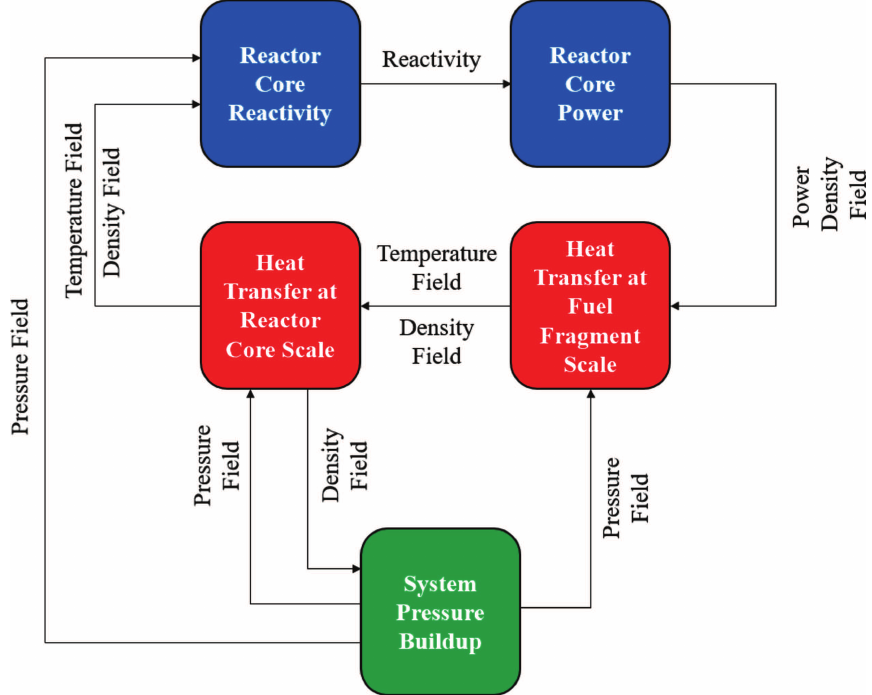
Fig. 2. Simplified coupling scheme of the described HCDA